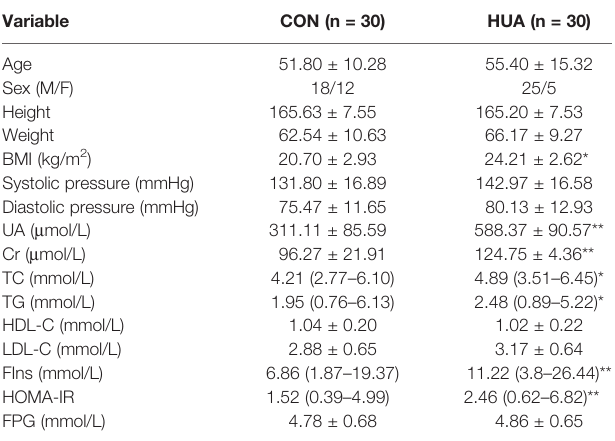
BMI,bodymassindex;CON,control groups;Cr,creatinine; FPG,fastingplasmaglucose; FIns, fasting insulin; HDL-C, high density lipoprotein cholesterol; HOMA-IR, HOMA insulin resistance index; HUA, hyperuricemia; LDL-C, low-density lipoprotein cholesterol; TC, total cholesterol; TG, triglycerides; UA, uric acid. Data are expressed as means ± SEM; *P < 0.05; **P <